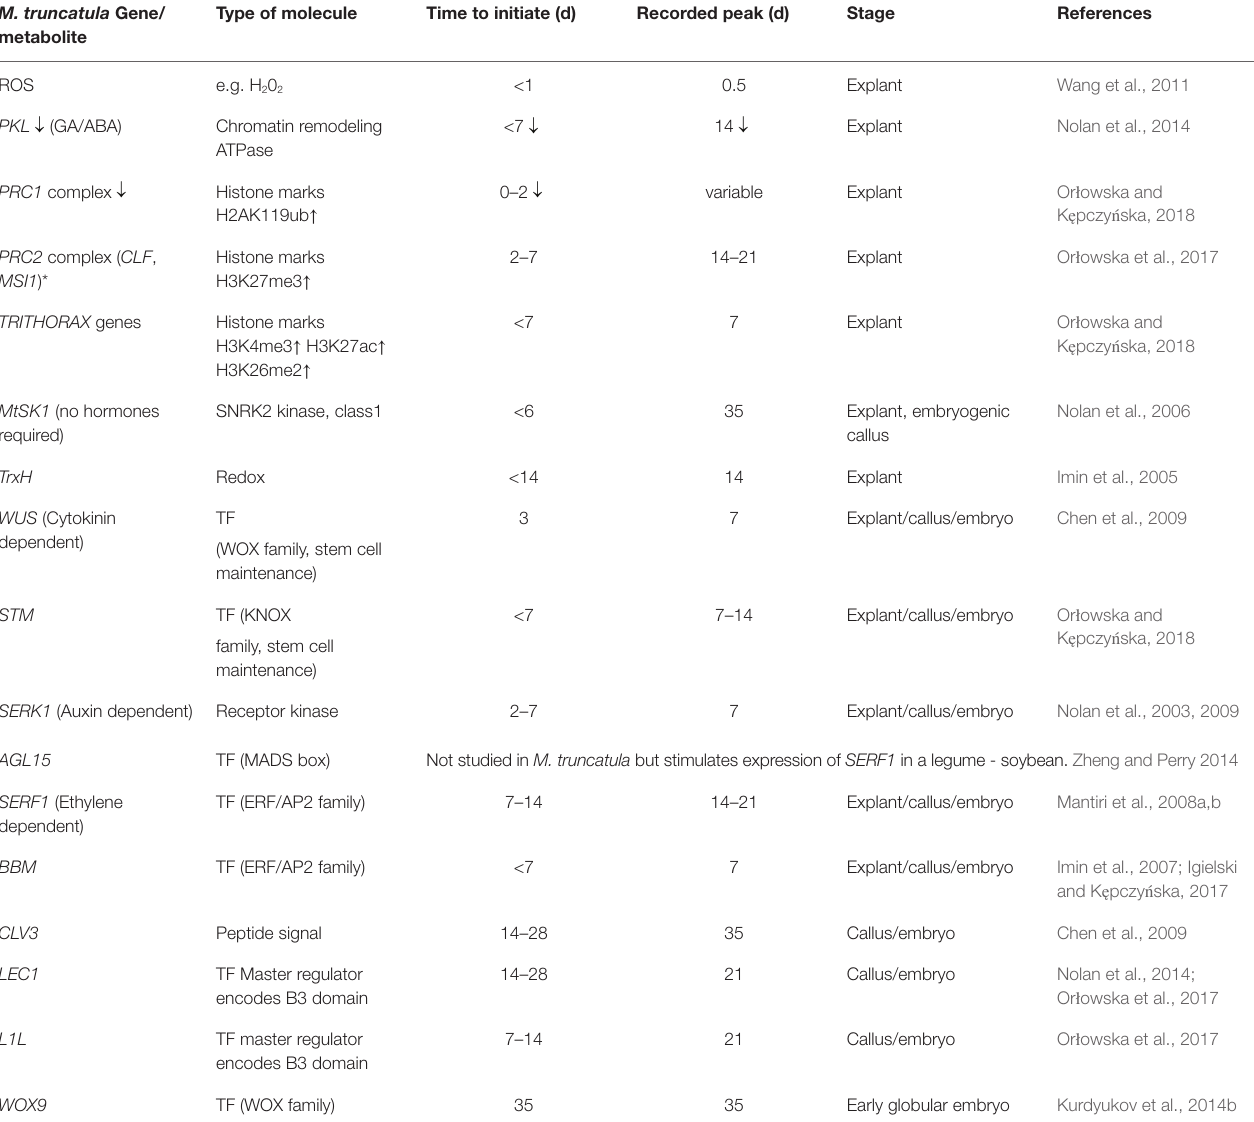
TABLE 2 | Sequence of changes of some key genes/metabolites in somatic